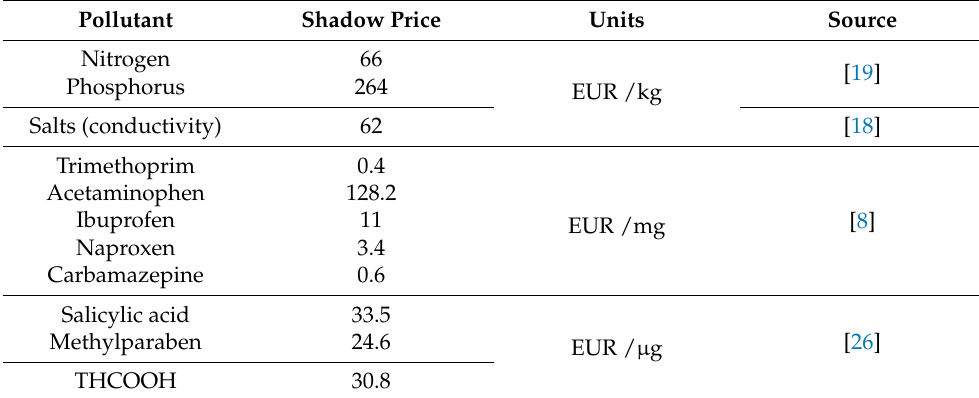
Table 4. Shadow price values for different wastewater pollutants obtained from the literature. Pollutant Shadow Price Units Source Nitrogen 66 EUR